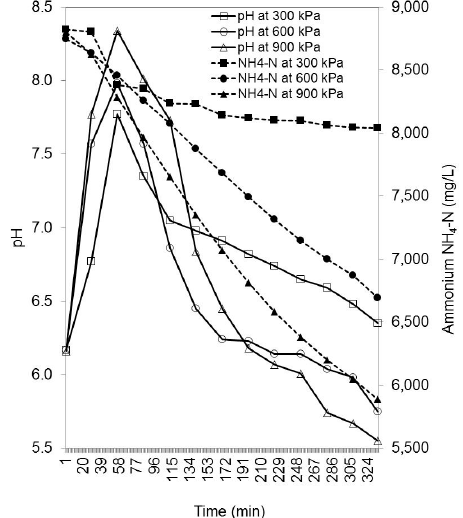
Figure 5. Relationship between pH (lines with open symbols) and NH 4 -N (lines with solid symbols) in the DSW during ammonia stripping within a 334 min timeframe at different pressures. Overpressure caused firstly abrupt short-term alkalization of DSW with pH peaks at 60 min after the start of pressure and stripping, but later the DSW acidified again. The ammonium nitrogen (NH 4 -N) content of the DSW linearly declined over 334 min of the process.